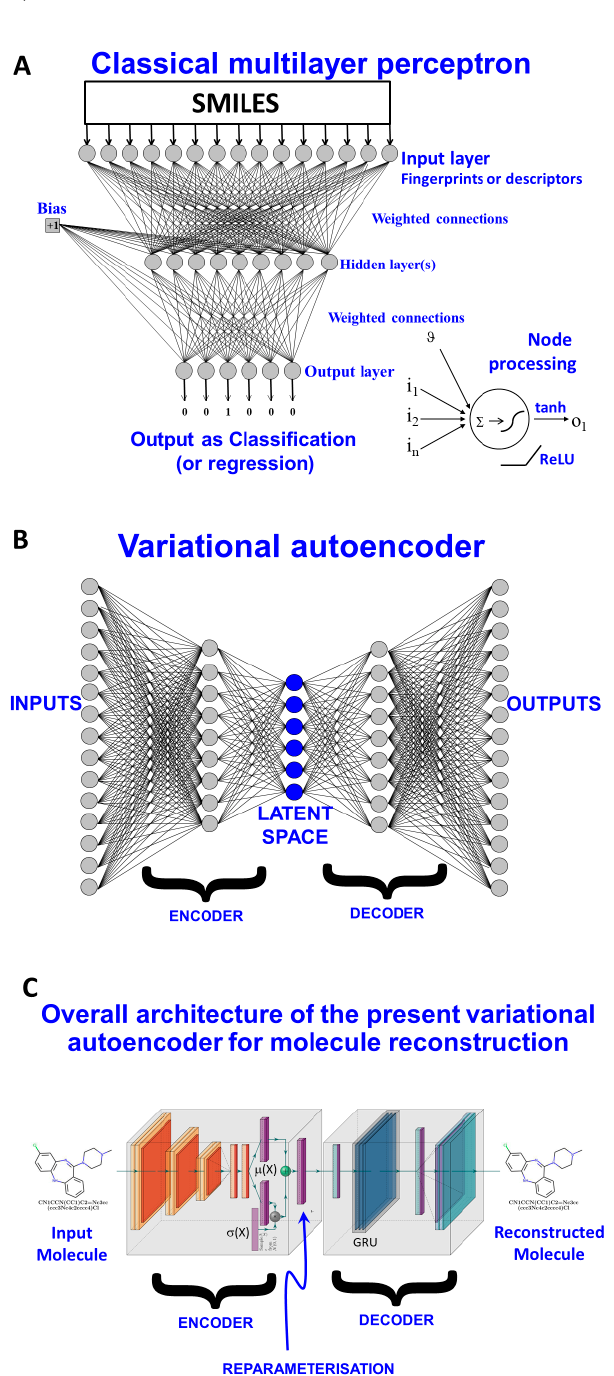
Figure 2. Two kinds of neural architecture. ( A ) A classical multilayer perceptron representing a supervised learning system in which molecules encoded as SMILES strings can be used as paired inputs with outputs of interest (whether a classification or a regression). The trained model may then be interrogated with further molecules and the output ascertained. ( B ) A variational autoencoder, is a supervised means of fitting distributions of discrete models in a way that reconstructs them via a vector in a latent space. ( C ) The variational autoencoder (VAE) architecture used in the present work. More recently, it was recognised that various kinds of architectures could, in fact, permit the reversal of this numerical encoding so as to return a molecule (or its SMILES string encoding a unique structure). These are known as generative methods [41–55], and at heart their aim to generate a suitable and computationally useful representation [56] of the input data. It is common (but cf. [57,58]) to contrast two main flavours: generative adversarial networks [59–66] and (especially